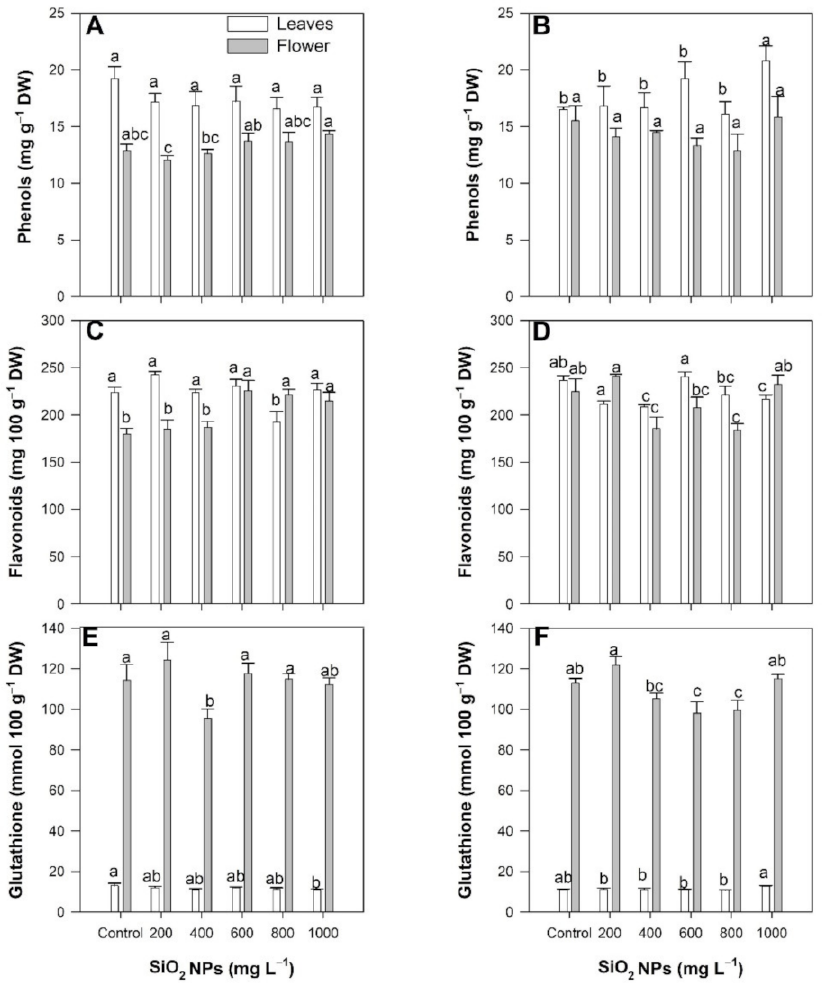
Figure 5. Effect of the application of SiO 2 NPs via the soil method ( A , C , E ) and the foliar method ( B , D , F ) on the non-enzymatic antioxidants: phenols ( A , B ), flavonoids ( C , D ), and glutathione ( E , F ). Different letters indicate significant differences according to Fisher’s least significant difference test ( p ≤